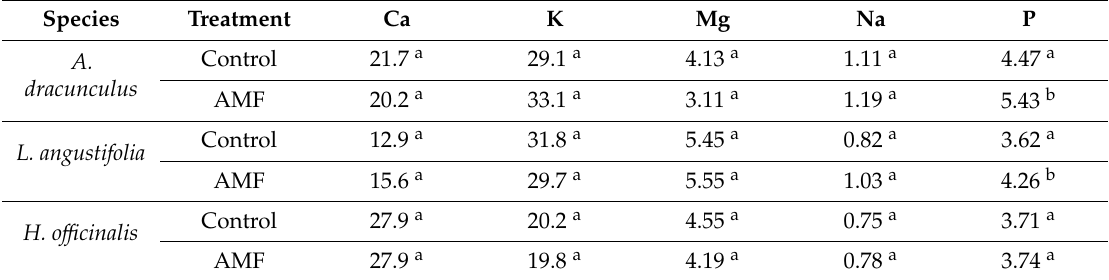
Table 4. Macro-element content in aromatic plants inoculated with AMF (g · kg − 1 dw). Species